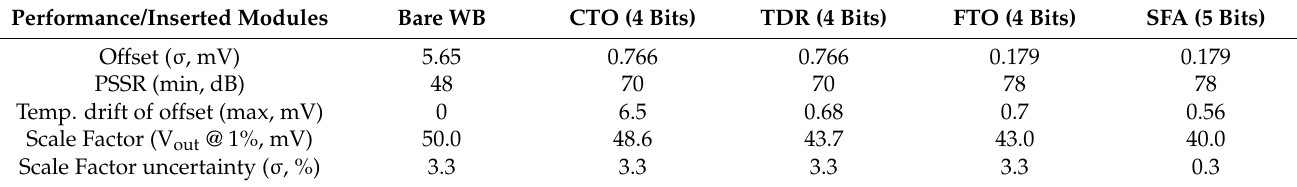
Table 2. Performance level of the proposed solution for post-manufacturing calibration of resistive sensors (MC simulations).